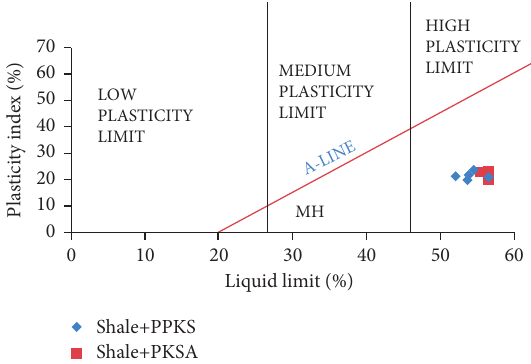
Figure 4: The Casagrande chart of the sampled